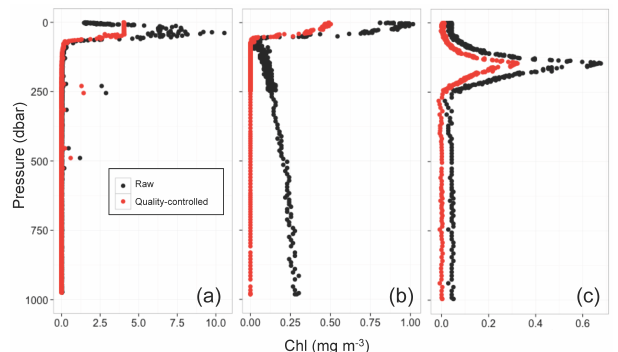
Figure 3. Raw and quality-controlled vertical profiles of chloro- phyll a concentration (Chl) for the following areas: (a) the North Atlantic subpolar gyre (float WMO 6901516), (b) the Black Sea (float WMO 7900591), and (c) the South Atlantic subtropical gyre (float WMO 6901439).